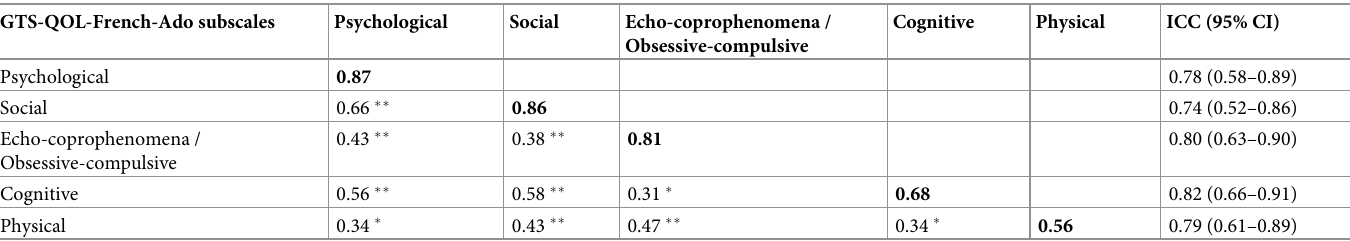
Table 4. Internal consistency, inter-subscale correlations and test-retest reliability for the GTS-QOL-French-Ado